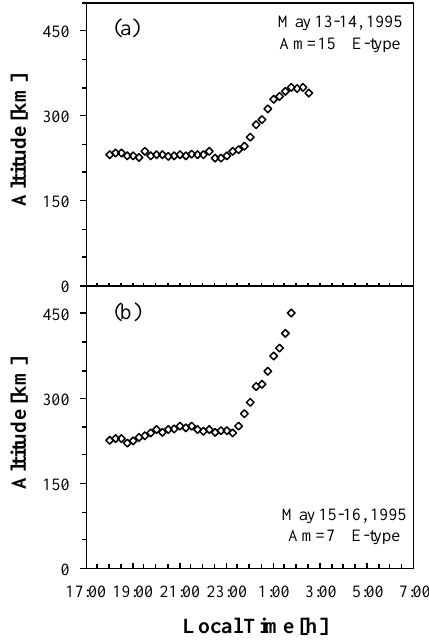
Figure 2. F-layer height variations as a function ofLT time showing non-fully developed E-type pattern. In (a) the layer has disappeared early after the peak; in (b) the layer has disappeared before the peak is reached.